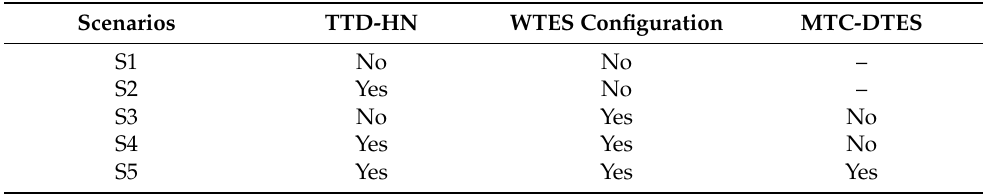
Figure 5. Structure diagram of the UEHIES in the case study. 5.1. Medium Temperature Characteristics In order to explore the influence of the MTC-DTES and TTD-HN models on the configuration scheme, five scenarios are used in this section; four WTES systems are configured first. The settings are shown in Table 1, and the configuration results of sce- narios S1–S5 are shown in Table 2.